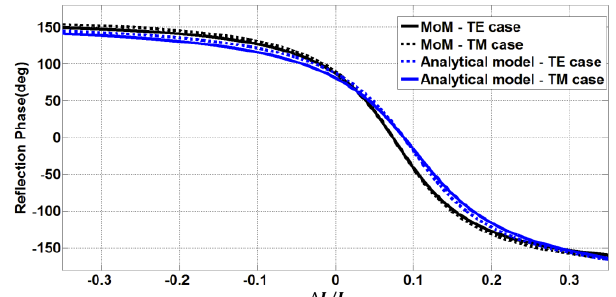
Figure 4: Phase of the reflected field versus patch size Figure 5: The required phase distribution on the aperture of the reflectarray. The operating frequency is 10 GHz, d= 30 cm and f/D=1